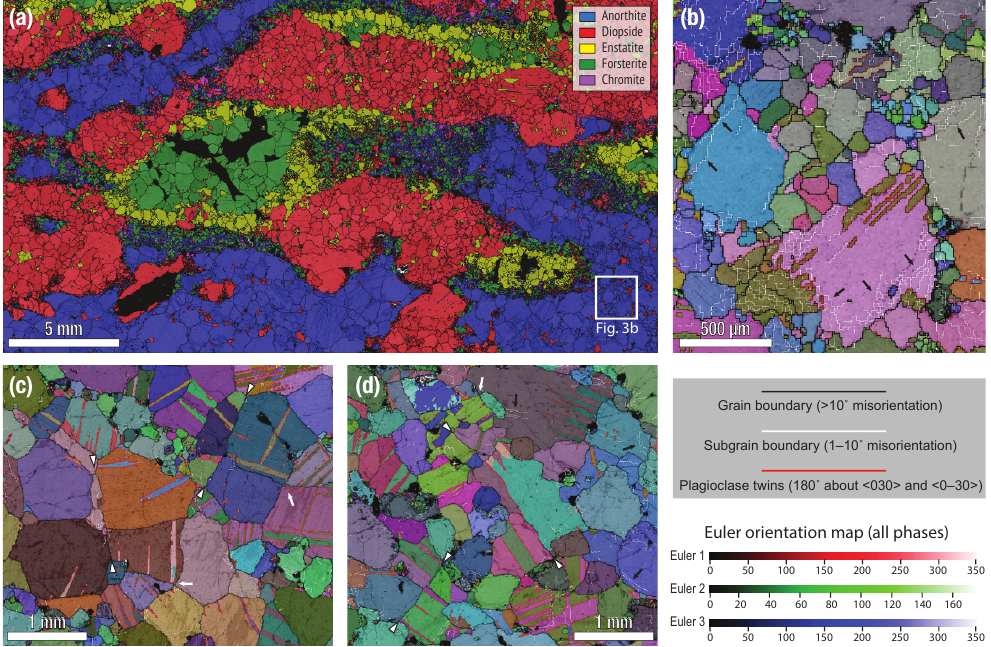
Figure 3. Examples of EBSD maps. All maps have an upper edge parallel to the observed lineation, with the foliation being normal to the map. (a) EBSD phase map layered on a band contrast map in granulite SQ-16. Please note the enstatite rims on olivine. (b–d) EBSD maps of Euler orientation layered on band contrast maps. The white box in (a) shows the location of (b) . Panel (c) shows xenolith SQW-75 and panel (d) shows SQW-115. Black arrows show subgrain boundaries in plagioclase. White arrows point to quadruple junctions. White triangles delineate aligned grain